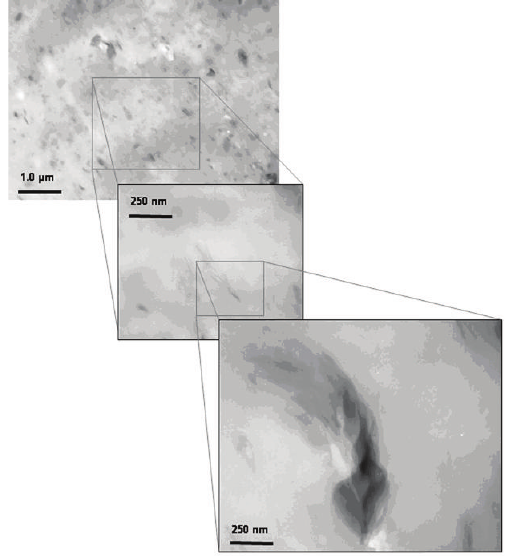
Figure 3: TEM image of nylon-6 film with 2wt% nanoclay.